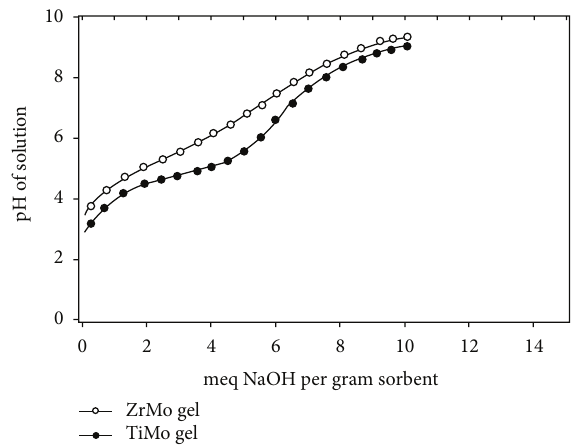
Figure 8: pH titration curves of molybdate solutions [57].